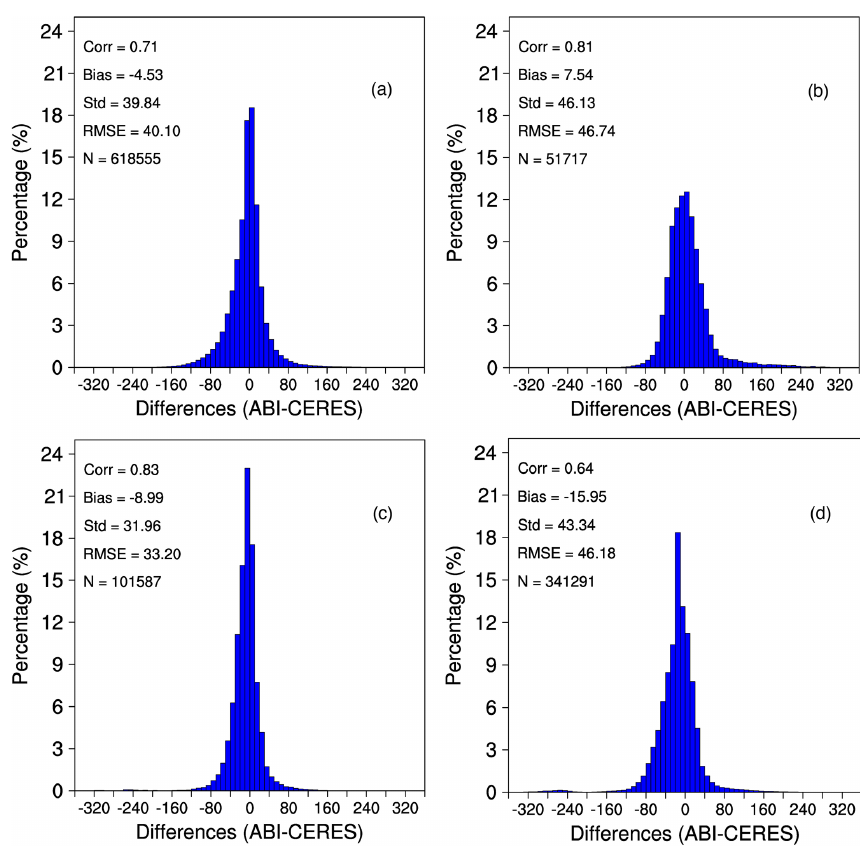
Figure 13. Same as Fig. 11 but for clear TOA SW